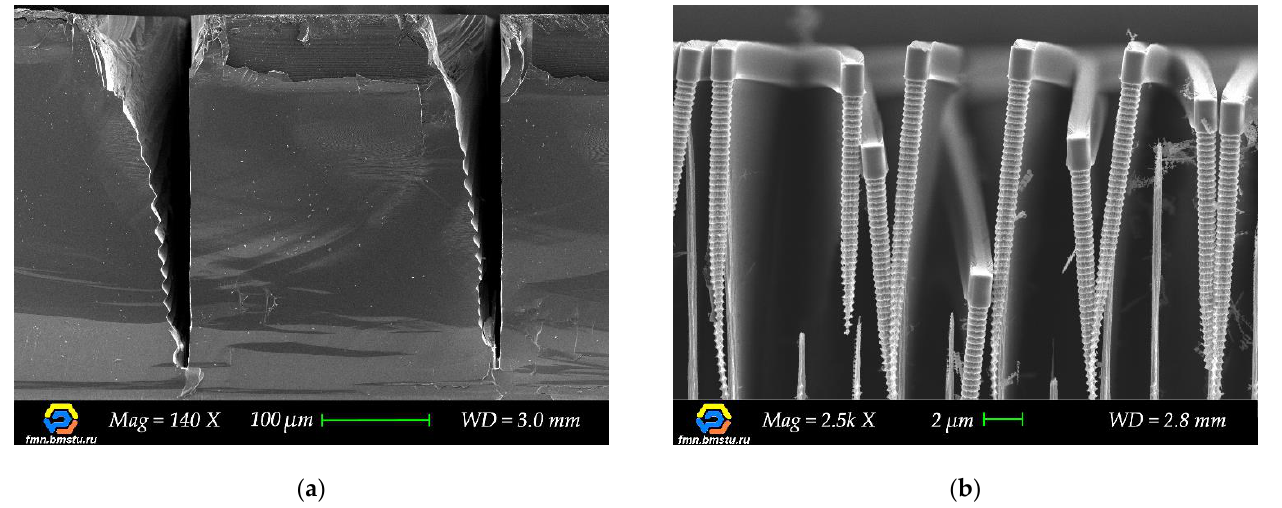
Figure 5. Scanning electron microscopy (SEM) images of cleaving defects: ( a ) Destruction of the upper part of the microstructure, which spreads downward due to the presence of a large number of stress concentrators; ( b ) Bending and destruction of 2- µ m structures under their weight due to additional etching at the intersection with auxiliary